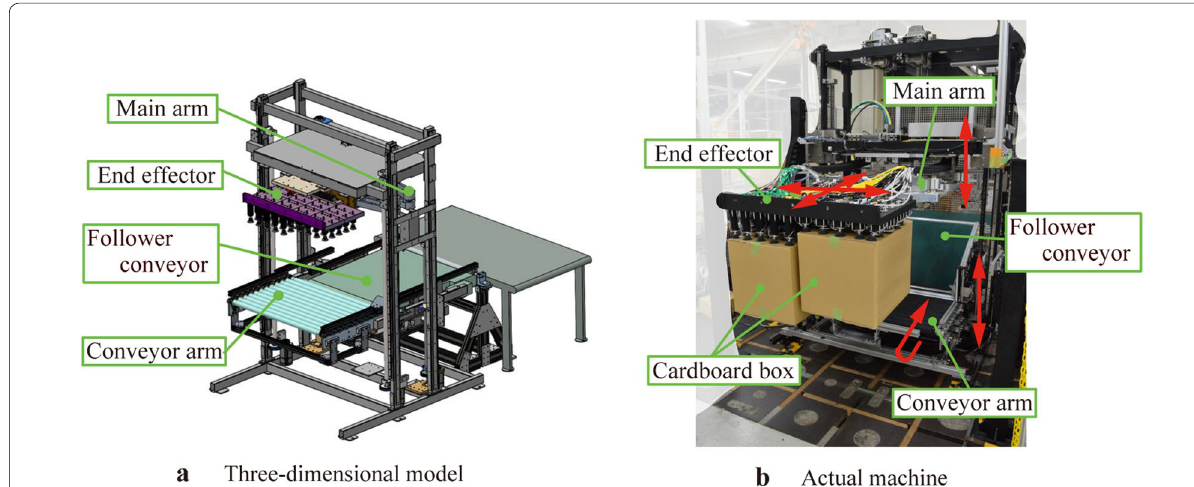
Fig. 22 Conventional linear-motion type depalletizing robot with the developed end-effector. a Three-dimensional model, b actual machine